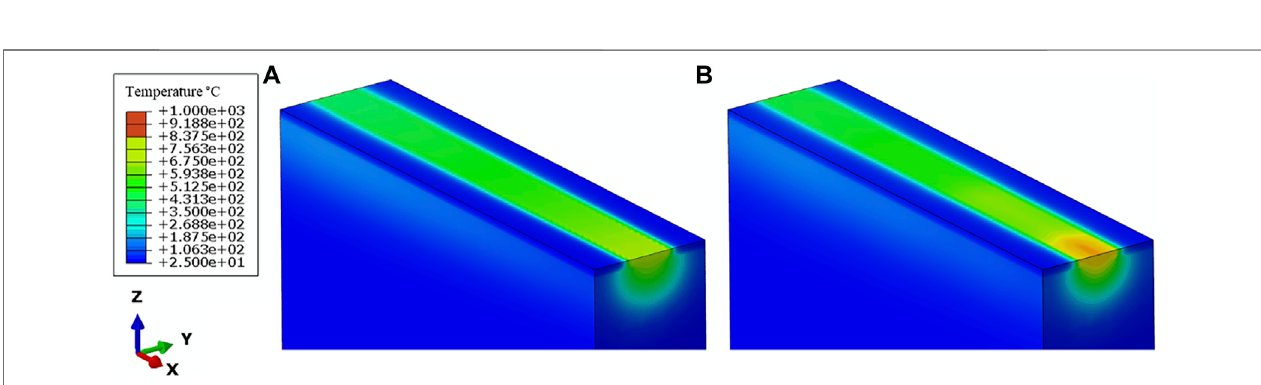
FIGURE 14 | Temperature distributions captured 1.2 ms after the track simulation fi nishes for (A) the ED beam scale and (B) the HL track-scale model ( τ (cid:2) 10).